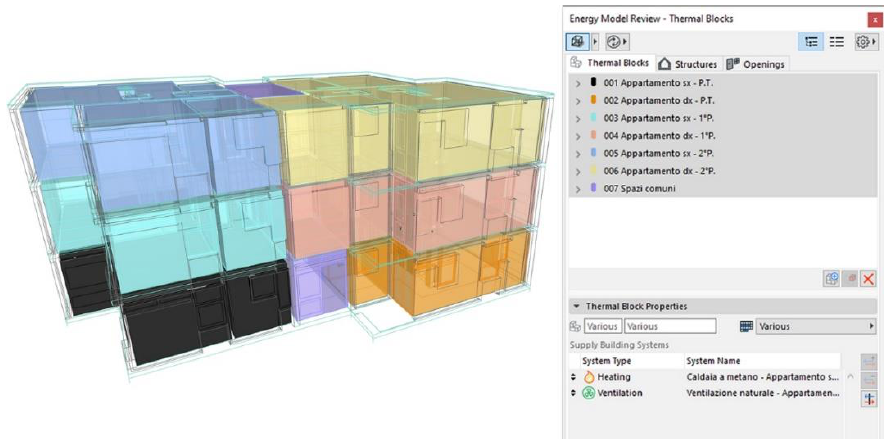
Figure 10. Graphic visualization of the Building Energy Model (BEM) model with chromatic distinction of the thermal blocks.